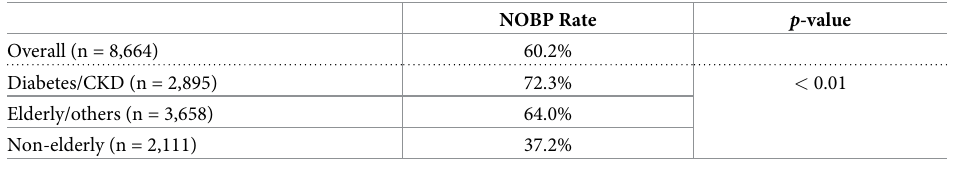
Table 2. Rate of non-attainment of optimal blood pressure (NOBP)